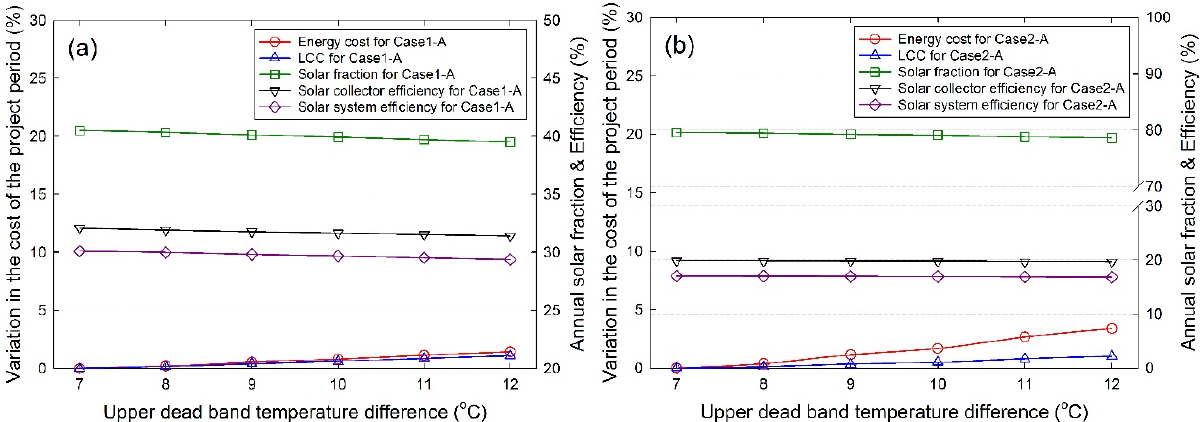
Figure 12. Effect of a difference in the temperature of the upper dead band of the differential temperature controller on the energy and economic performances of the SWH systems: ( a ) Case1-A and ( b )